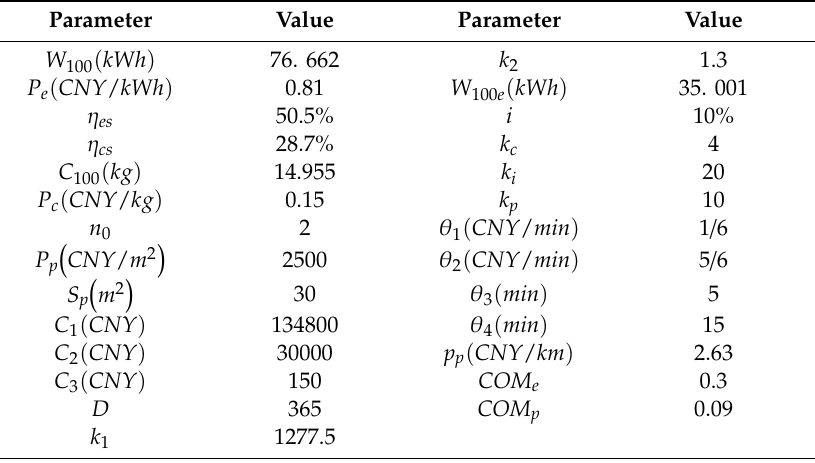
Table 1. Parameter value for game solving.